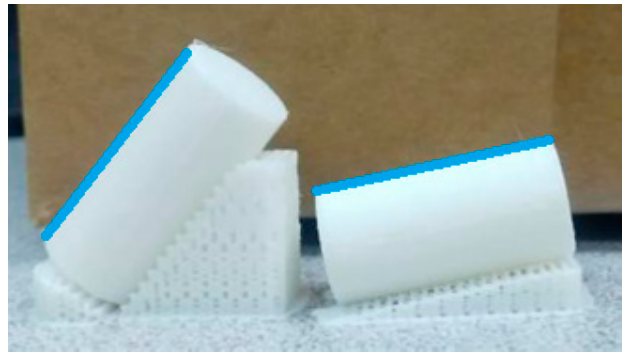
Figure 7. Printed specimens with the measurement direction highlighted in blue .